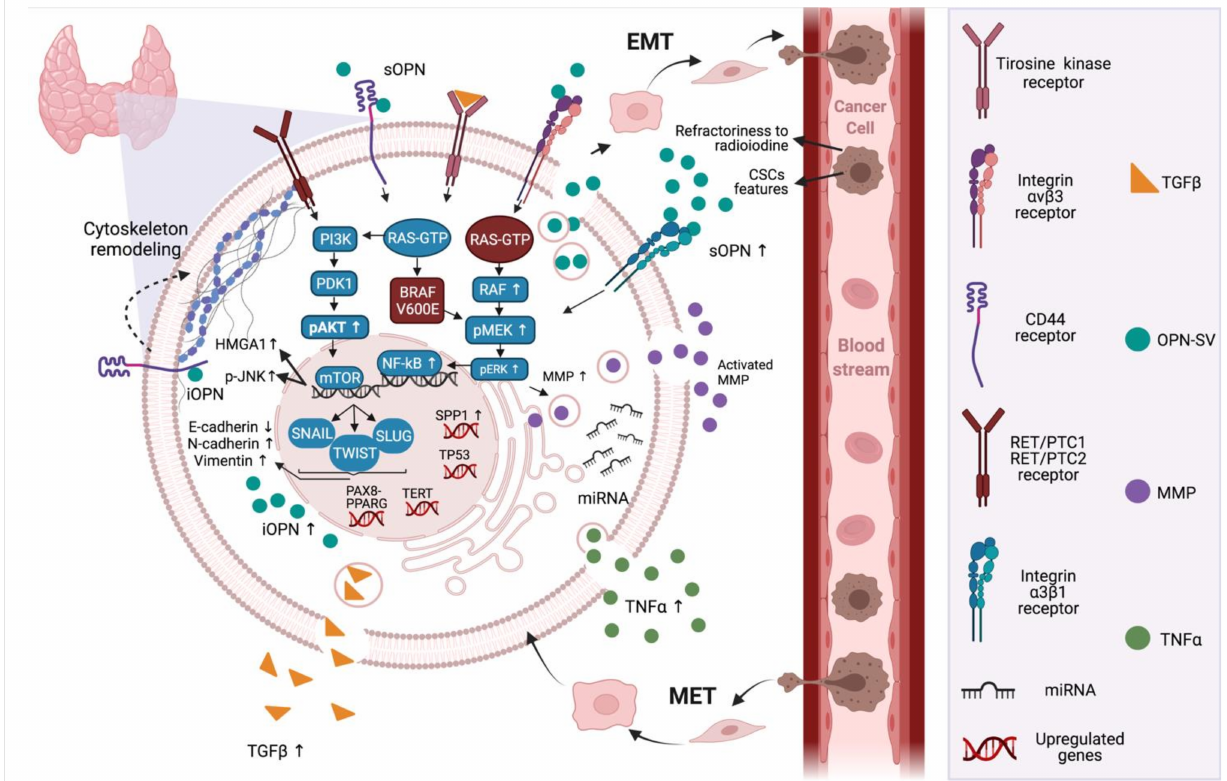
Figure 1. OPN signaling in the context of epithelial–mesenchymal plasticity in thyroid cancer cells. In thyroid cancer cells, OPN is a highly expressed protein that plays major roles in the regulation of the PI3K/AKT and MAPK signaling pathways. OPN can induce these pathways through interacting with its known receptors, CD44 and/or integrins. In thyroid cancer, the expression of OPN is related to mutated RAS and BRAF genes, in addition to chromosomal rearrangements of RET . These pathways lead to the expression of transcription factors, including NF- κβ , SLUG, SNAIL and TWIST, which are correlated with cellular plasticity and tumor progression. Further, other genes are likely to be mutated in thyroid cancer, such as the oncogene TERT , PAX8-PPARG fusion and the tumor suppressor gene TP53 . Furthermore, the inducing of transcription factors related to EMT, OPN-SV plays direct roles in activating extracellular MMPs by binding to integrin receptors and activating signaling pathways including MAPK. Additionally, intracellular OPN can regulate cytoskeleton remodeling through the CD44 receptor, which are pivotal steps to increased cell migration, invasion and metastases. In addition, TNF α and TGF β can be regulated by OPN and can, in turn, regulate the expression of OPN. OPN seems to also be a target for miRNAs, which are related to the regulation of the EMT process. Moreover, the expression of OPN is correlated with the expression of p-JNK and HMGA1b. In thyroid cancer, OPNa is the most expressed OPN-SV and potentially induces EMT. As a result of these events, thyroid cancer follicular cells acquire mesenchymal features, through the downregulation of E-cadherin and the upregulation of mesenchymal markers such as N-cadherin and vimentin, which are pivotal to the establishment of metastasis and refractoriness to radioiodine. Mutations in thyroid cancer are expressed differently among the subtypes of cancer, which causes the diversity of prognostics and overall survival. Up arrows mean levels increase and down arrows mean levels decrease. Created with BioRender.com (accessed on 28 July